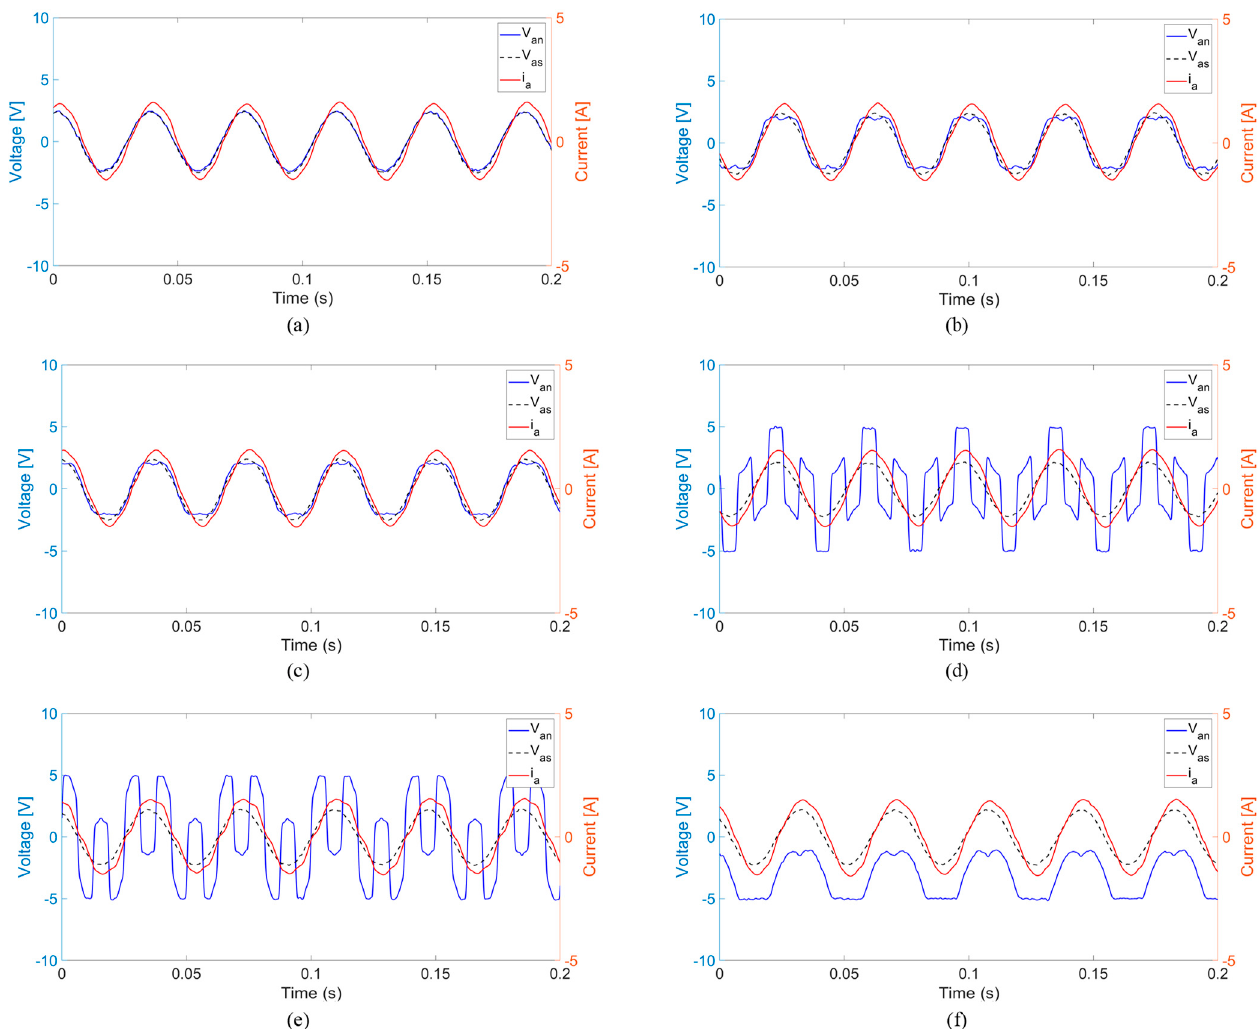
Figure 16. Experimental results at 400 rpm and 1.5 A depending on the PWM technique: ( a ) SPWM; ( b ) THPWM; ( c ) SVPWM; ( d ) 60° DPWM; ( e ) 30° DPWM; ( f ) 120° (off) DPWM.